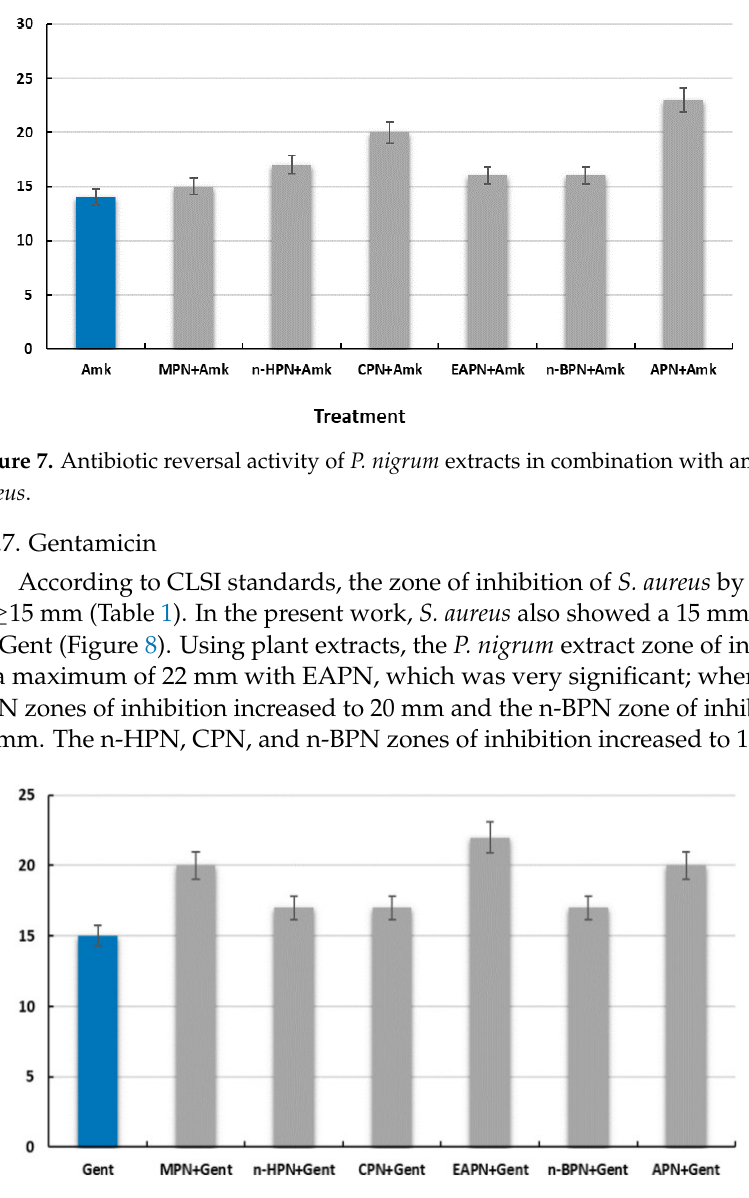
Figure 6. Antibiotic reversal activity of P. nigrum extracts in combination with ciprofloxacin (5 μg) for S. aureus